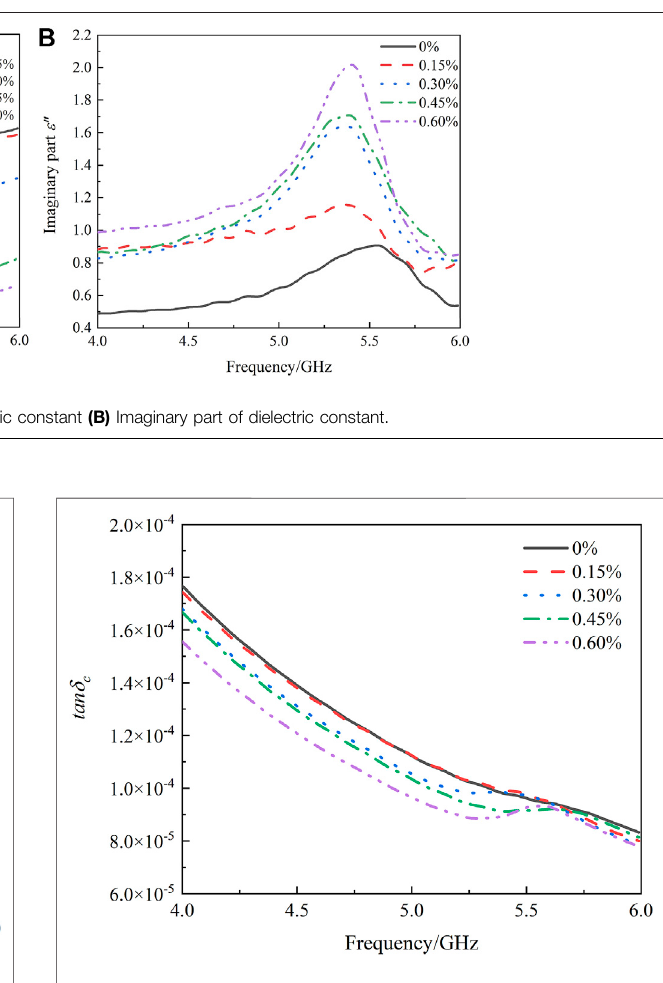
FIGURE 5 | Dielectric loss tangent curve with frequency.